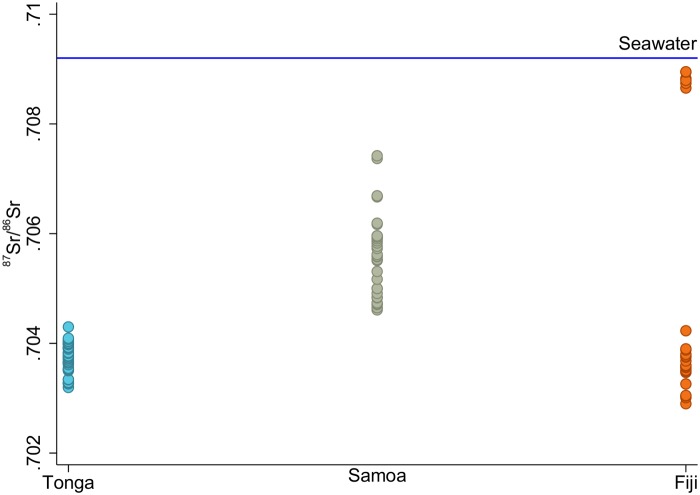

87Sr/86Sr isotopic compositions of Tonga, Samoan, and Fijian archipelagoes.Solid line is 87Sr/86Sr value of modern seawater (0.7092). Data from [87–90].